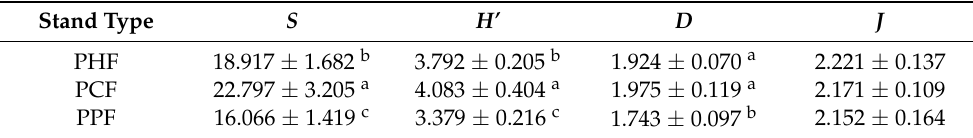
Table 5. The total of each plant’s diversity indices for the three stands. Stand